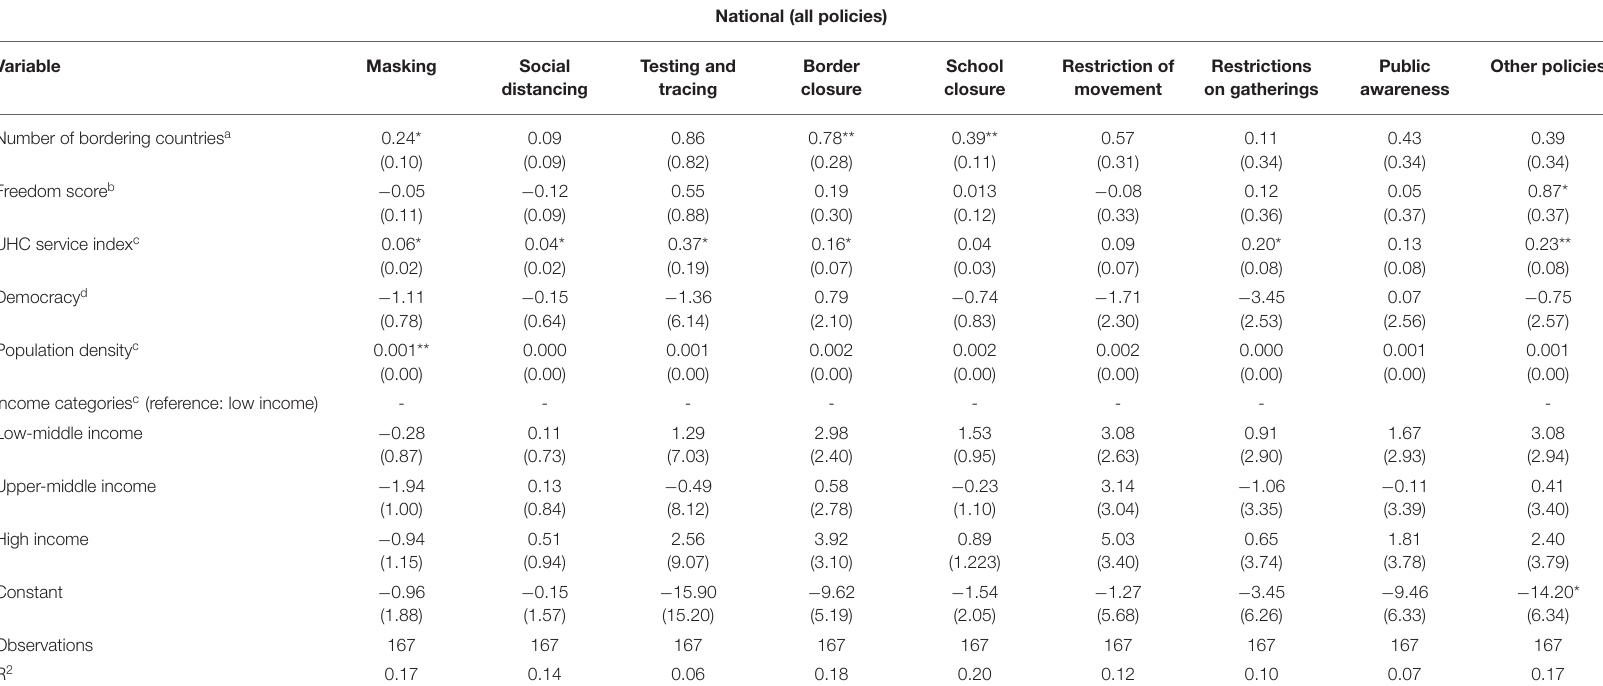
National (all policies)